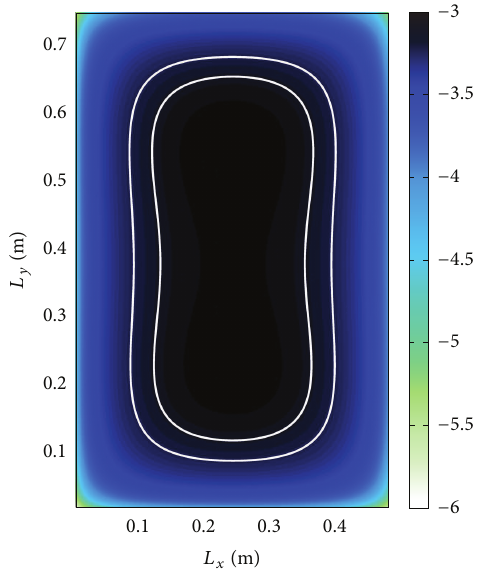
Figure 4: WSSG field summed over the first 15 modes, at the 1, 2 mode natural frequency, in dB relative to the maximum value on the plate. The inner white line represents the 3dB down contour and the outer one represents the 6 dB